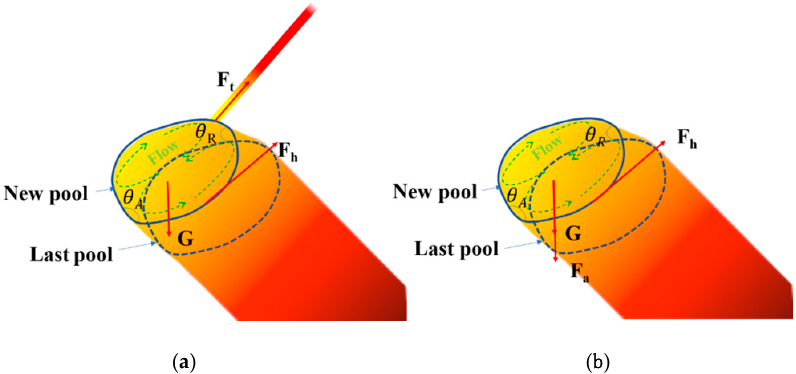
Figure 13. ( a ) Diagram of force analysis during wire feeding; ( b ) Diagram of force analysis during molten pool transition .